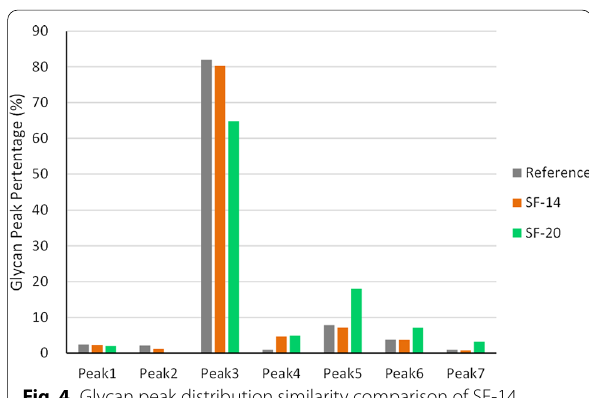
Fig. 4 Glycan peak distribution similarity comparison of SF-14, SF-20 and the reference. The distance of SF-14 is the shortest to the reference, while the distance of SF-20 is the longest to the reference. The peaks percentage of SF-14 is similar to the peaks percentage of reference